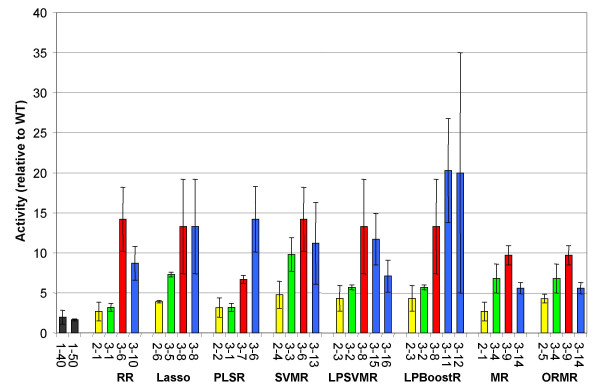
Activities of variants designed using substitution weights. Activities towards N-Succinyl-Ala-Ala-Pro-Leu p-nitroanilide were measured at 37°C following a 5 minute heat treatment of the enzyme at 68°C. Activities are expressed relative to the mean activity of duplicates of wild-type proteinase K. Error bars represent one standard deviation of the activity measurements. Variants are grouped according to the machine learning algorithm used to calculate substitution weights (indicated below each group), and are compared with the best variants from the initial design set (variants 1–40 and 1–50 black bars, on the left). The first design (yellow bars, design method G in Additional file 2) of each group belongs to set 2. We included a substitution in the design if it occurred at least three times in the training set and its mean weight was at least one standard deviation above zero. All remaining designs in each group belong to set 3. The second in each group (green bars, design method J in Additional file 2) includes substitutions occurring at least three times and whose mean weights were merely positive (eg Figure 3A, red and blue circles). The third in each group (red bars, design method K in Additional file 2) contained all substitutions occurring at least three times and whose mean weight was at least one standard deviation above zero (eg Figure 3A, red circles). Note that this third design in each group is always better than the second. The last variant(s) in each group (blue bars, design method L in Additional file 2) were designed by modeling interdependent substitutions (eg Figure 3B, red circles).